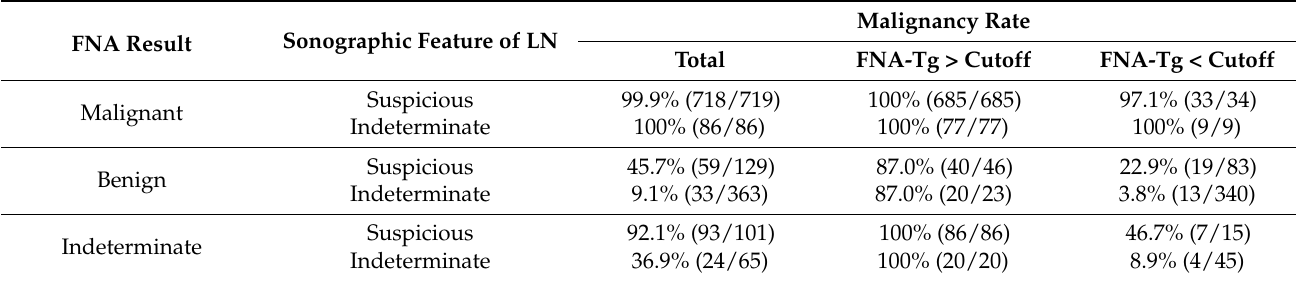
Table 3. Malignancy rate of lymph nodes (LNs) according to the sonographic feature, fine-needle aspiration cytology results, and washout thyroglobulin